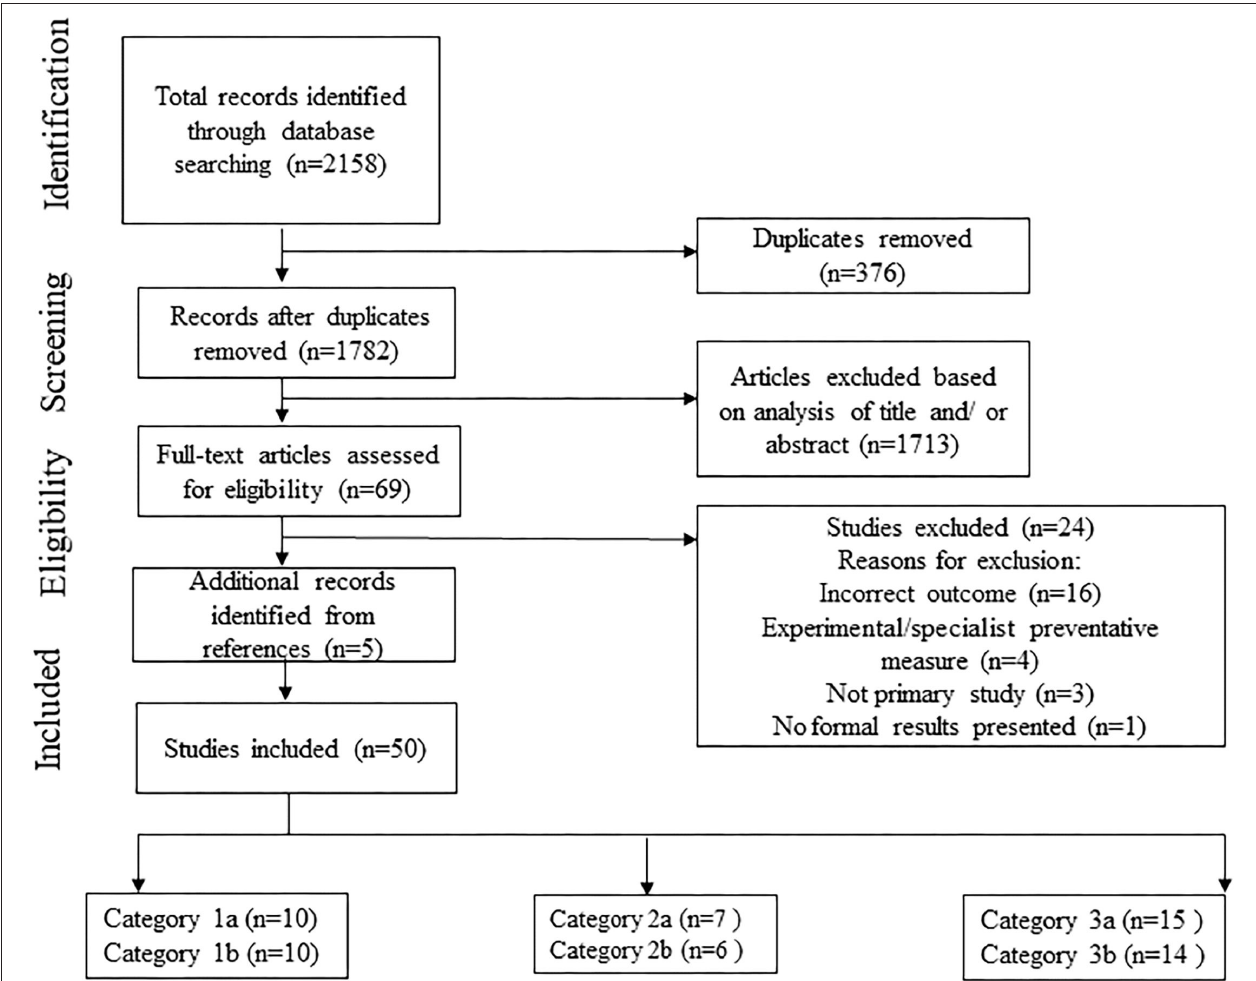
FIGURE 1 | PRISMA flow diagram that details the search and selection process applied during the scoping review. Sum of studies from subcategories > 50 as some studies addressed more than one